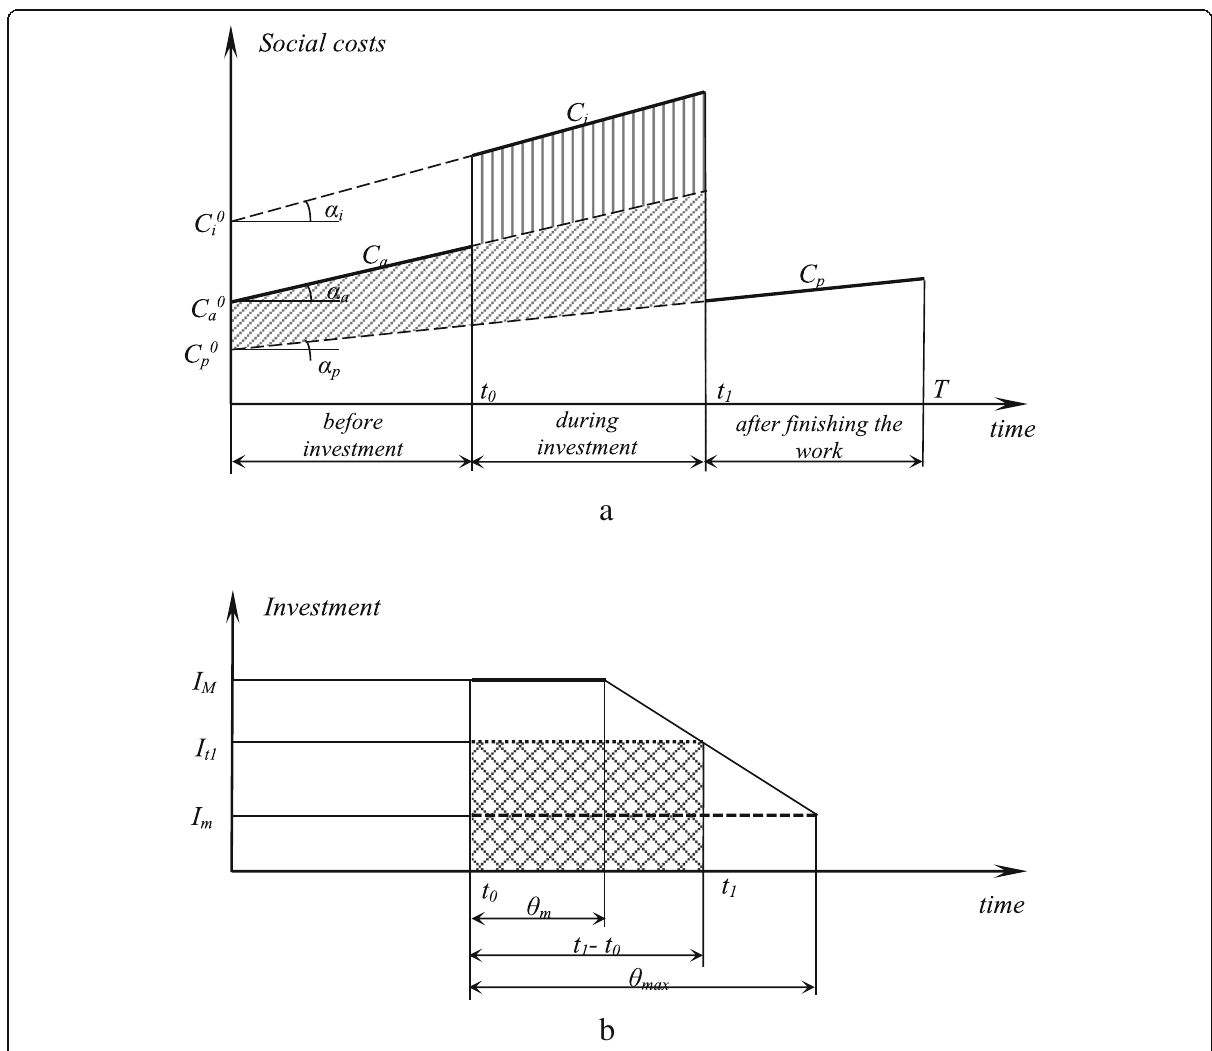
Fig. 9 Social costs before, during and after the work in relationship with the amount of investment. ( a ) Total costs in the “ no-project ” situation (Ca), during the work (Ci) and after the completion of the work (Cp). ( b ) The amount of investment, depending on the completion